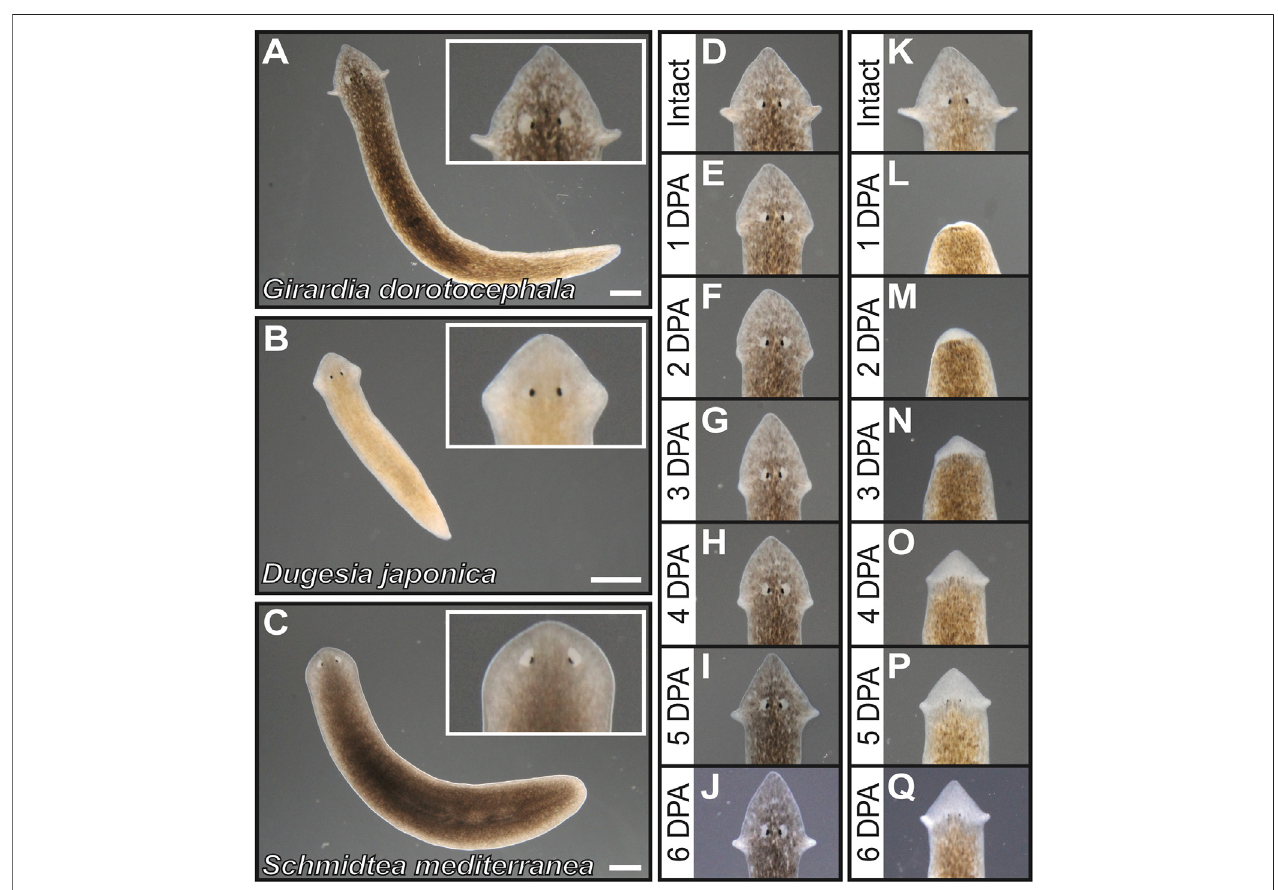
FIGURE 1 | Girardia dorotocephala as research organisms for the study of auricle function and regeneration. (A – C) Dark (cid:2) fi eld images of live specimens of G. dorotocephela (A) , Dugesia japonica (B) and sexual biotype Schmidtea mediterranea (C) . (D – Q) Dark fi eld images of G. dorotocephela undergoing auricle (D – J) and head (K – Q) regeneration. Images of intact (D,K) planarians, as well as daily timepoints from one to 6 days post-amputation (DPA) display the regenerative process that occurs within a week. Scale bars (cid:2) 1 mm.